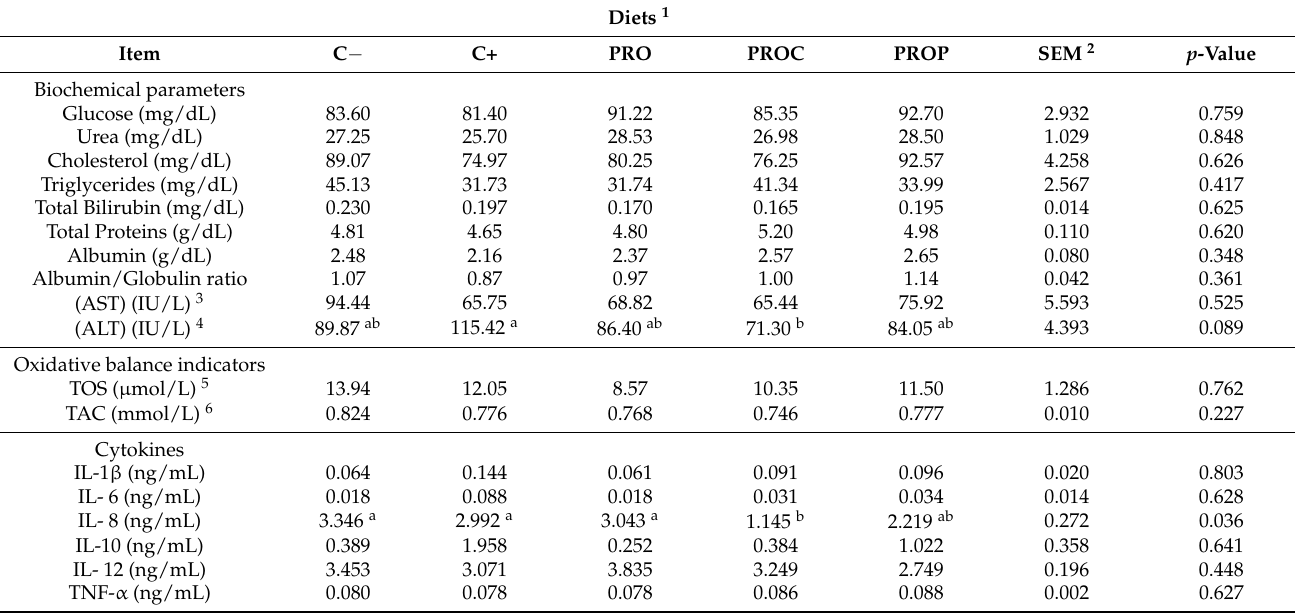
Table 6. General biochemical parameters, oxidative balance indicators and cytokines in serum of piglets feed with experimental diets at 25 days post-weaning. Diets